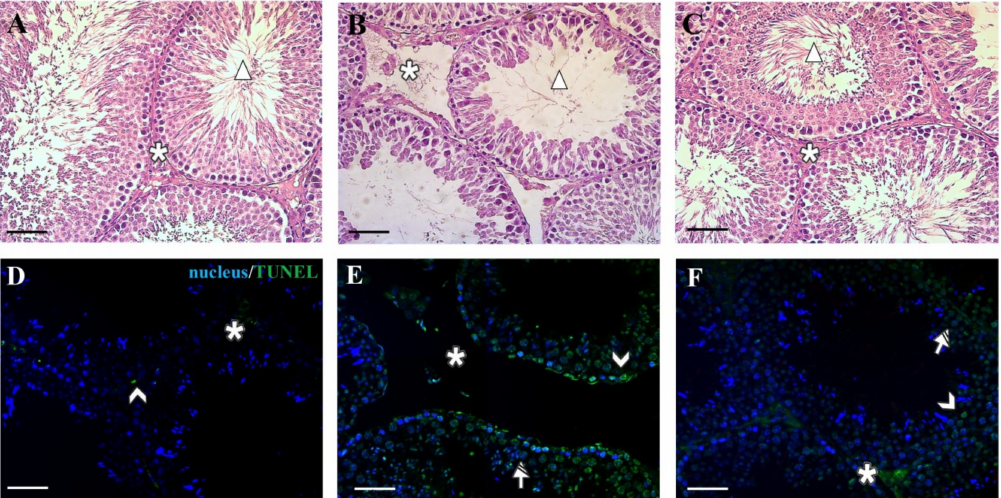
Figure 2. Hematoxylin-eosin and TUNEL staining of rat testicular paraffin-embedded sections. ( A – C ): Hematoxylin-eosin staining of control ( A ), EDS ( B ), and D-Asp + EDS ( C ) treated rat testes. The absence of Leydig cells in the EDS-treated group is evident; ( D , E ): Determination of apoptotic cells through the detection of TUNEL-positive cells (green) in control ( D ), EDS ( E ), and D-Asp + EDS ( F ) treated rats. Slides were counterstained with DAPI-fluorescent nuclear staining (blue). The images were captured at × 20 magnification. Scale bars represent 20 µ m. Asterisks: Leydig cells. Triangles: luminal Spermatozoa. Arrowheads: Spermatogonia; Striped Arrows: